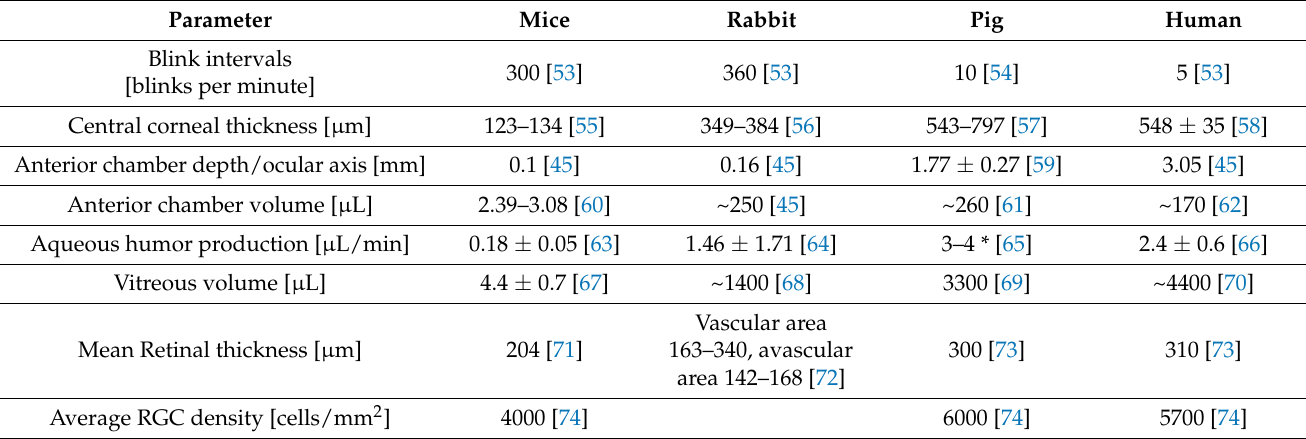
Table 2. Ocular characteristics of commonly used preclinical models vs. the human eye (modified and supplemented according to Wang et al.